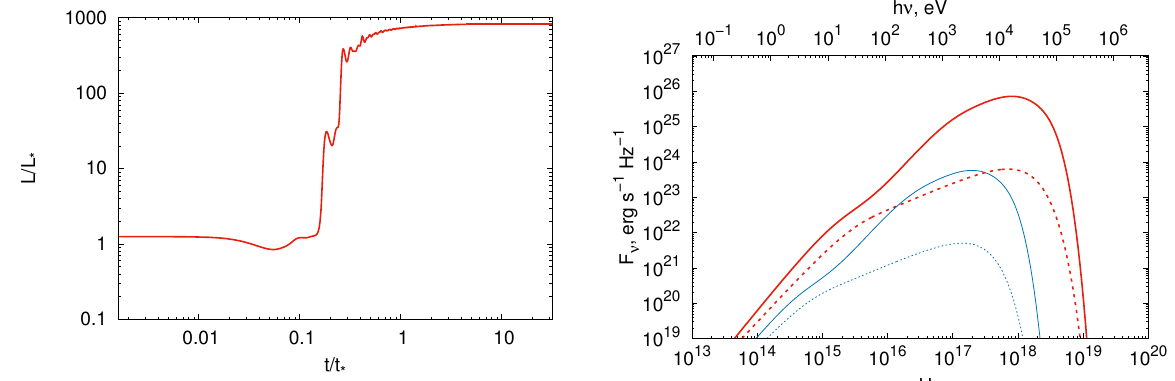
Figure 5. Dependence of bolometric luminosity on time L ( t ) L ( t ) L ( t ) (left). Electromagnetic radiation spectra F ν F ν F ν for radiative (thin lines) and convective (bold lines) disks. Solid lines describe the spectra of disturbed disks (at time t = 31 . 4 t ∗ t = 31 . 4 t ∗ t = 31 . 4 t ∗ ), and dotted lines show the corresponding spectra of undisturbed